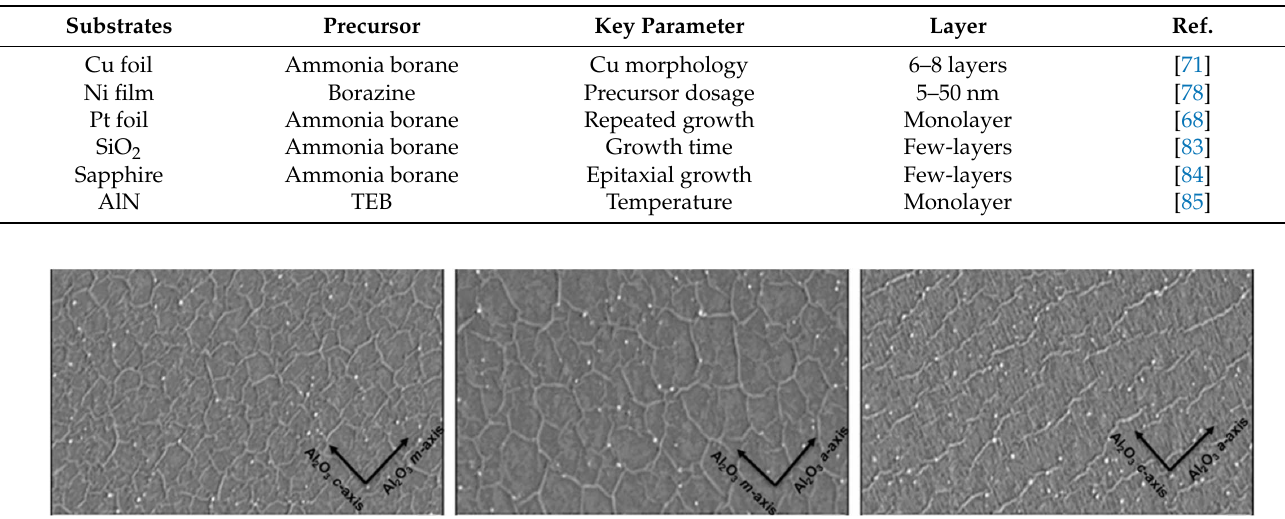
Table 4. A summary of the growth of 2D h-BN synthesized on various substrates using CVD.